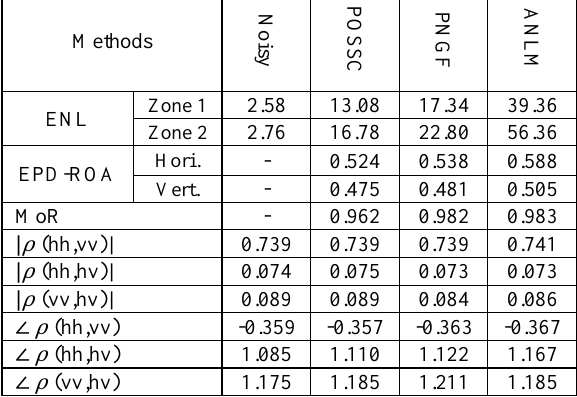
Table 1. ENL, EPD-ROA, MoR, and ρ values